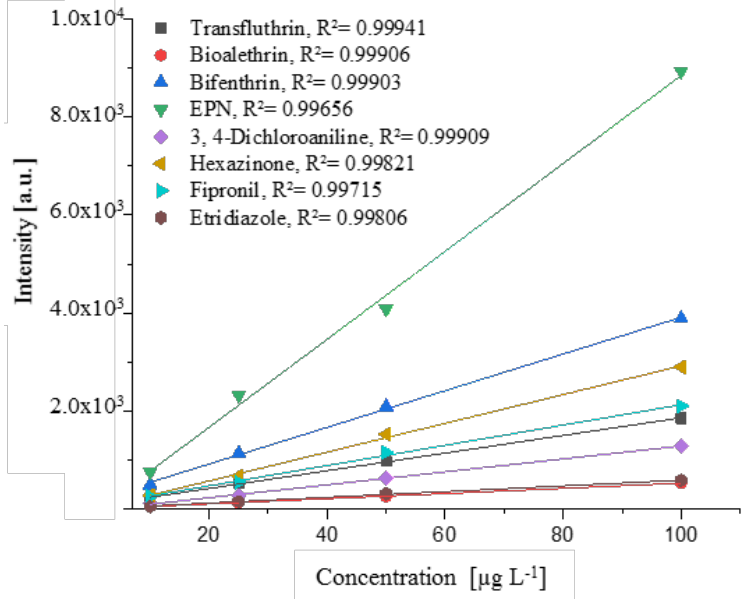
Figure 5. Relationship between concentration of the compound (µg L −1 ) and signal intensity (a.u.) for selected compounds of different pesticide classes. Linear regression curves were obtained with correlation coefficients R 2 > 0.997.